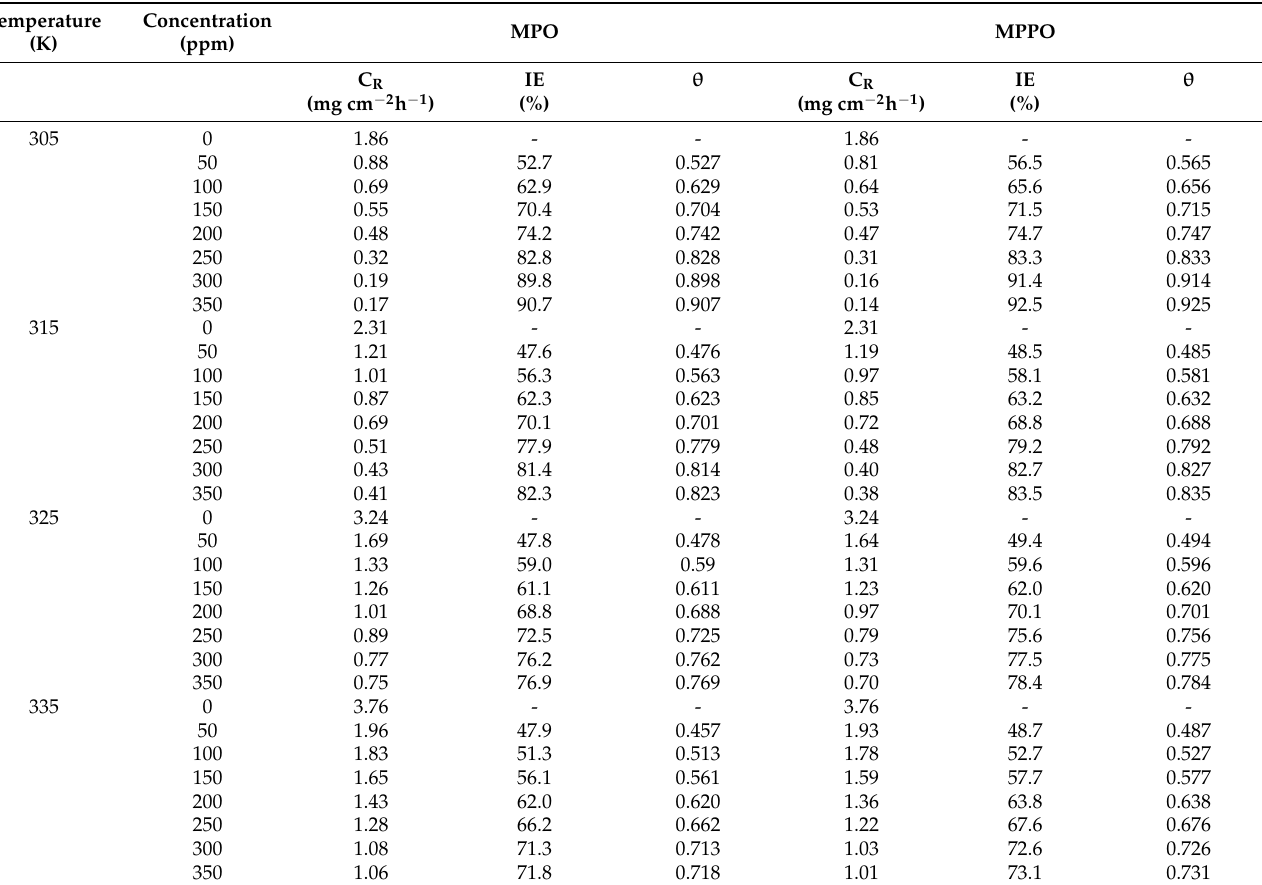
Table 1. Corrosion parameters obtained by weight loss measurements of N80 steel in 1.0 M HCl containing various concentrations of MPO and MPPO at different